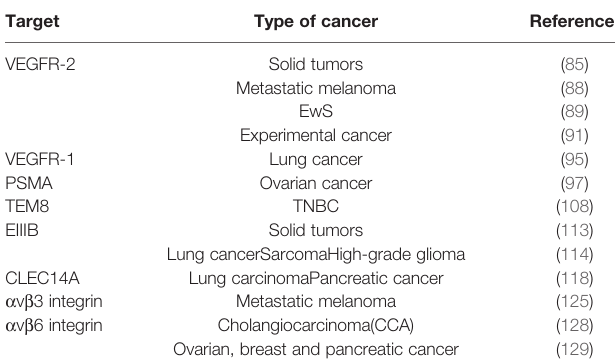
TABLE 2 | Summary of preclinical studies on proangiogenic factors/receptors- targeting CAR-T cells. Target Type of cancer